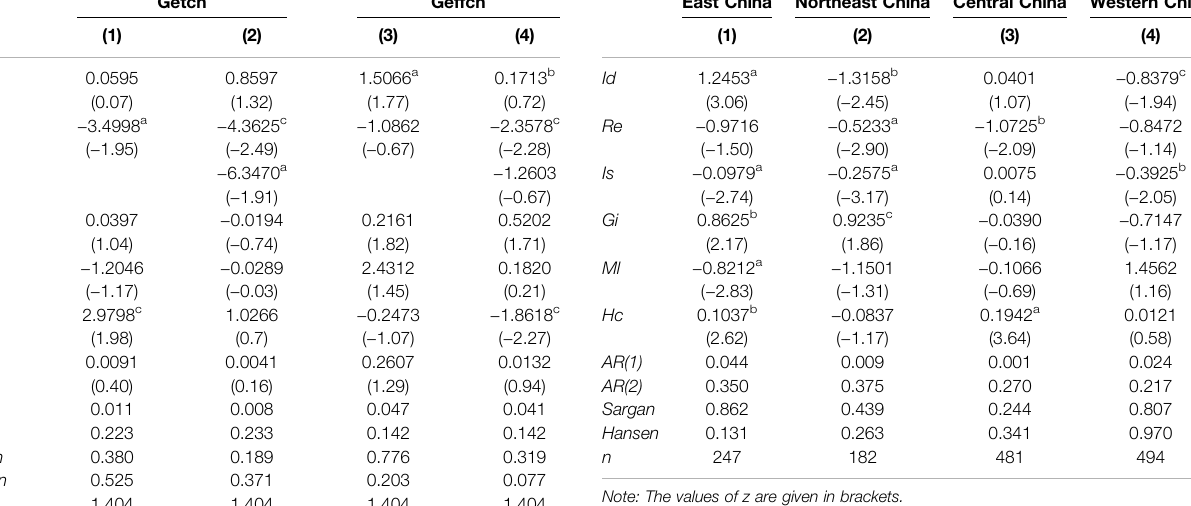
Table 7 re fl ects the heterogeneity analysis results of different regions of resource-based cities. According to the p values of the estimated parameters of the model, AR (1), AR (2), and Sargan and Hansen statistics, the setting of the model was reasonable.